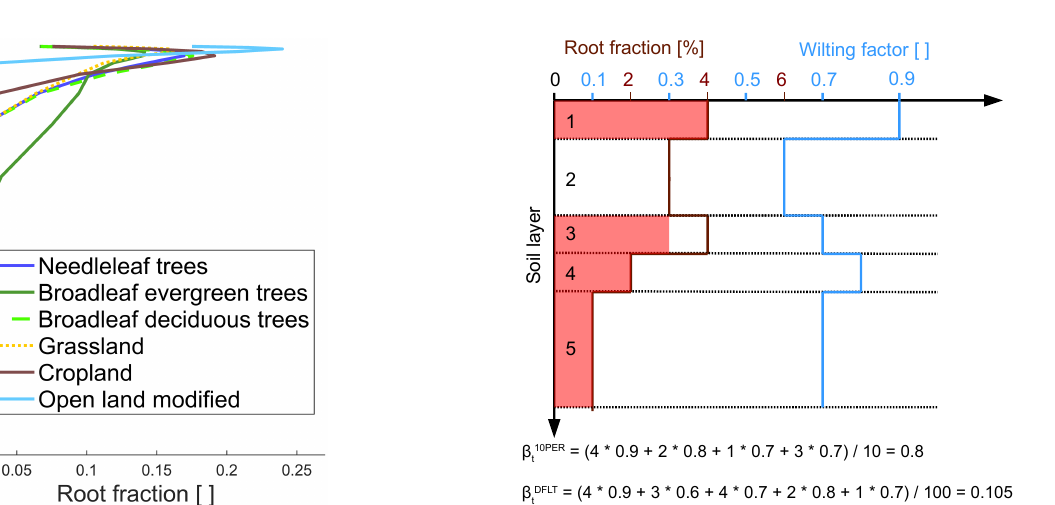
Figure A5. Vertical root fraction distribution of the different PFTs in the default version of CLM4.5 and (in light blue) the modified root fraction distribution of open land PFTs used in CLM-PLUS. The asterisks mark the reported maximum rooting depths of Fan et al. (2017) for annual grass (yellow), evergreen needleleaf trees (dark blue), deciduous broadleaf trees (light green), and evergreen broadleaf trees (dark green).